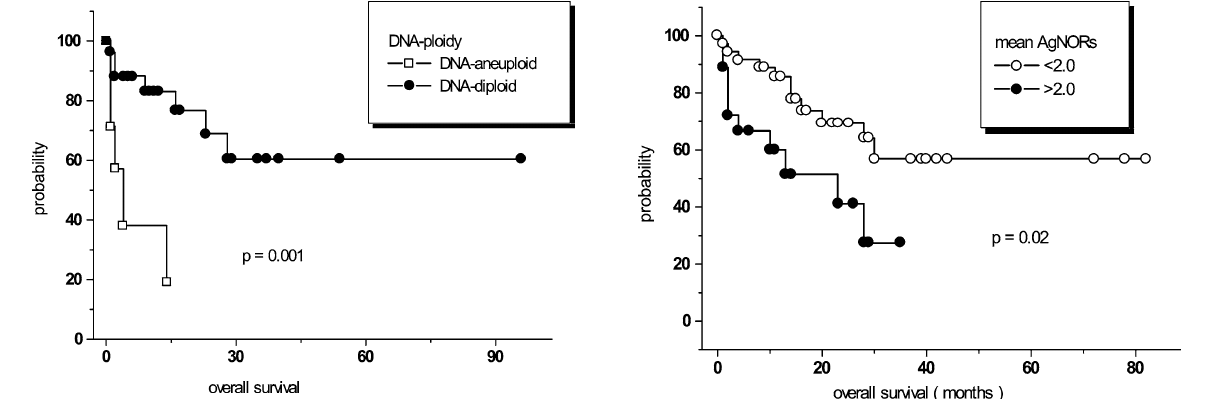
Fig. 5. Overall survival of the patients grouped by “total number of AgNORs/nucleus” below and above 2.0. This threshold was able to separate patients with a significantly different